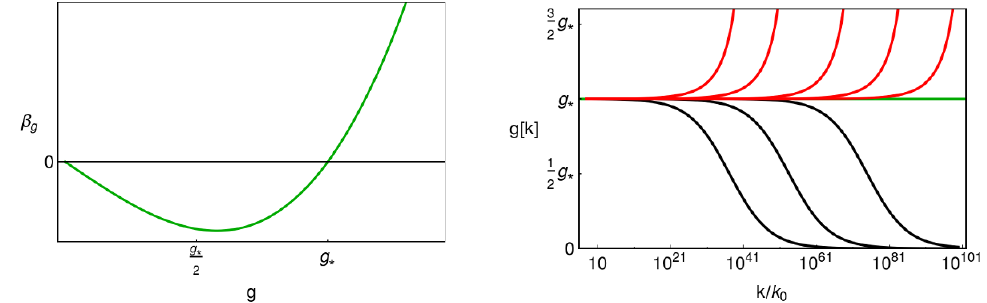
Figure 3 . We illustrate the beta function (left panel) arising from f g < 0 in eq. (4.3) and the corresponding RG trajectories (right panel). The interaction (cid:12)xed point at g (cid:3) generates an upper bound on low-energy values of g : no value above the green line in the right panel can be reached on a UV complete